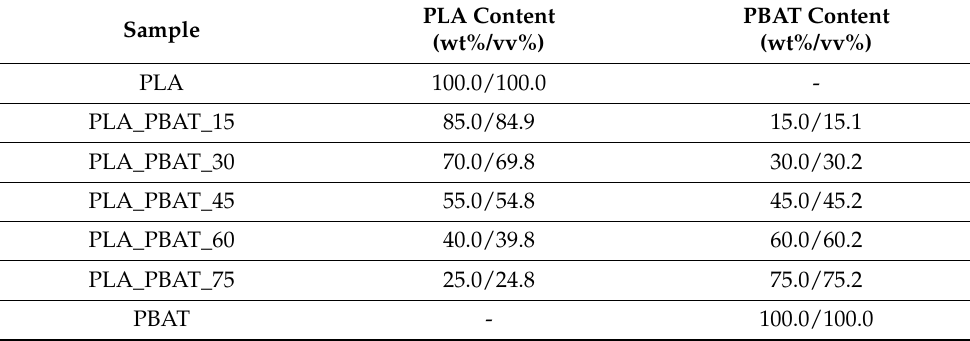
Table 1. List of the prepared samples and their nominal